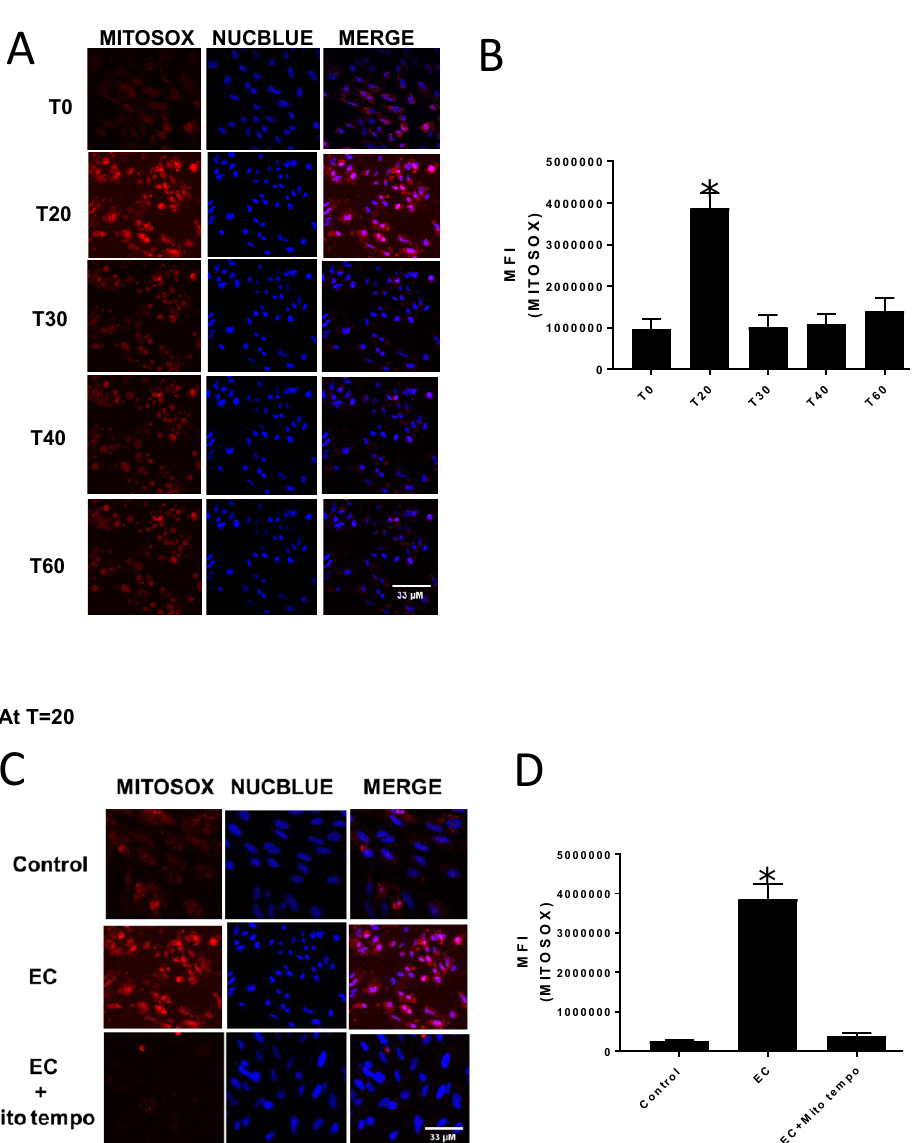
Figure 2. Monitoring mitochondrial superoxide production in whole cells. (A ) Confocal images of control and elesclomol:copper (E:C)-treated (70 µ M) CV-1 cells at various time points after staining with the mitochondria-specific superoxide indicator MitoSOX and the nuclear stain NucBlue Live. ( B ) Quantification of MitoSOX fluorescence intensity in CV-1 cells at the di ff erent time points after E:C treatment. ( C ) Confocal images of MitoSOX fluorescence intensity in CV-1 cells at the 20-min time point after E:C treatment in the presence and absence of the mitochondrial superoxide scavenger MitoTEMPO. (D ) Quantification of MitoSOX fluorescence intensity in CV-1 cells at the 20-min time point after E:C treatment in the presence and absence of the mitochondrial superoxide scavenger MitoTEMPO. Images in the NucBlue Live channel were adjusted to improve visual clarity. This adjustment does not a ff ect the quantification. A minimum of three cells / field and three fields / slide were imaged for each plate at 20 × magnification using a Zeiss confocal microscope. The images were analyzed using Image J software, and the change in mean fluorescence among groups was plotted. Normality of distribution of the data was determined using the D-Agostino Omnibus test. A one-way ANOVA analysis was performed followed by a Dunn’s post hoc test using GraphPad Prism software (San Diego, CA, USA) to identify statistical di ff erence among the samples. N = 3 for each condition; N represents one glass-bottomed 35 mm petri dish. * p < 0.05 vs control or